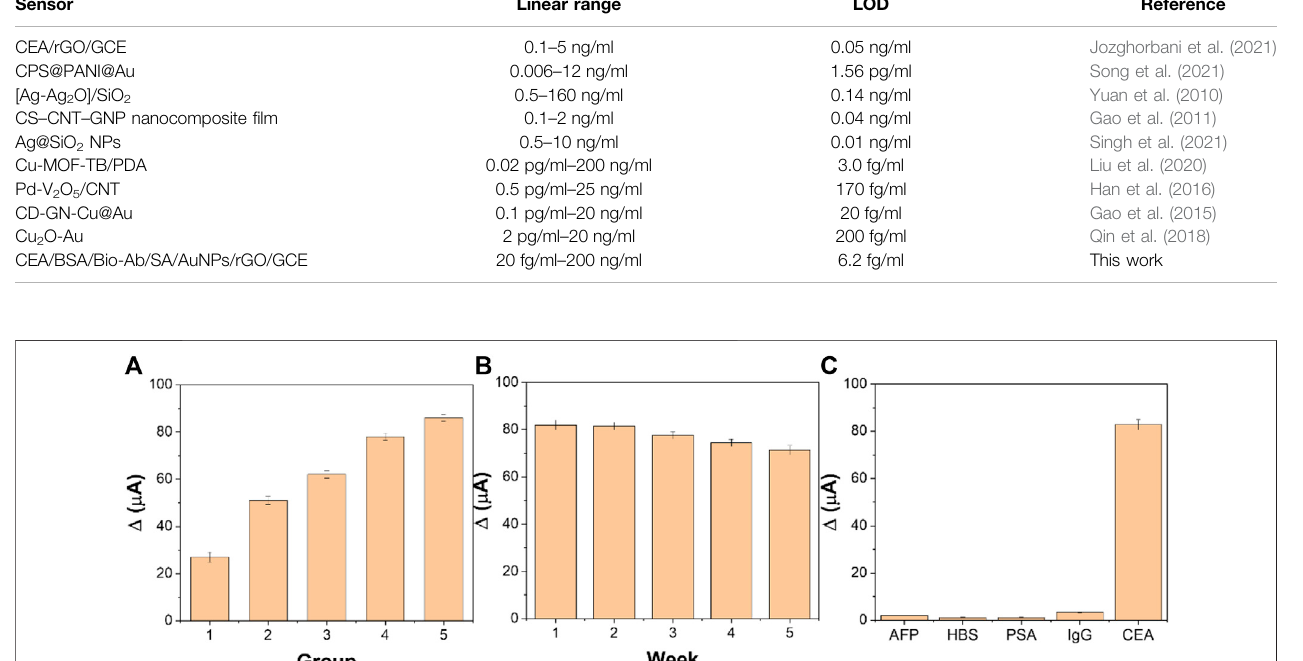
TABLE 1 | Linear range and LOD obtained using a proposed immunosensor and other sensors reported for CEA sensing. Sensor Linear range LOD